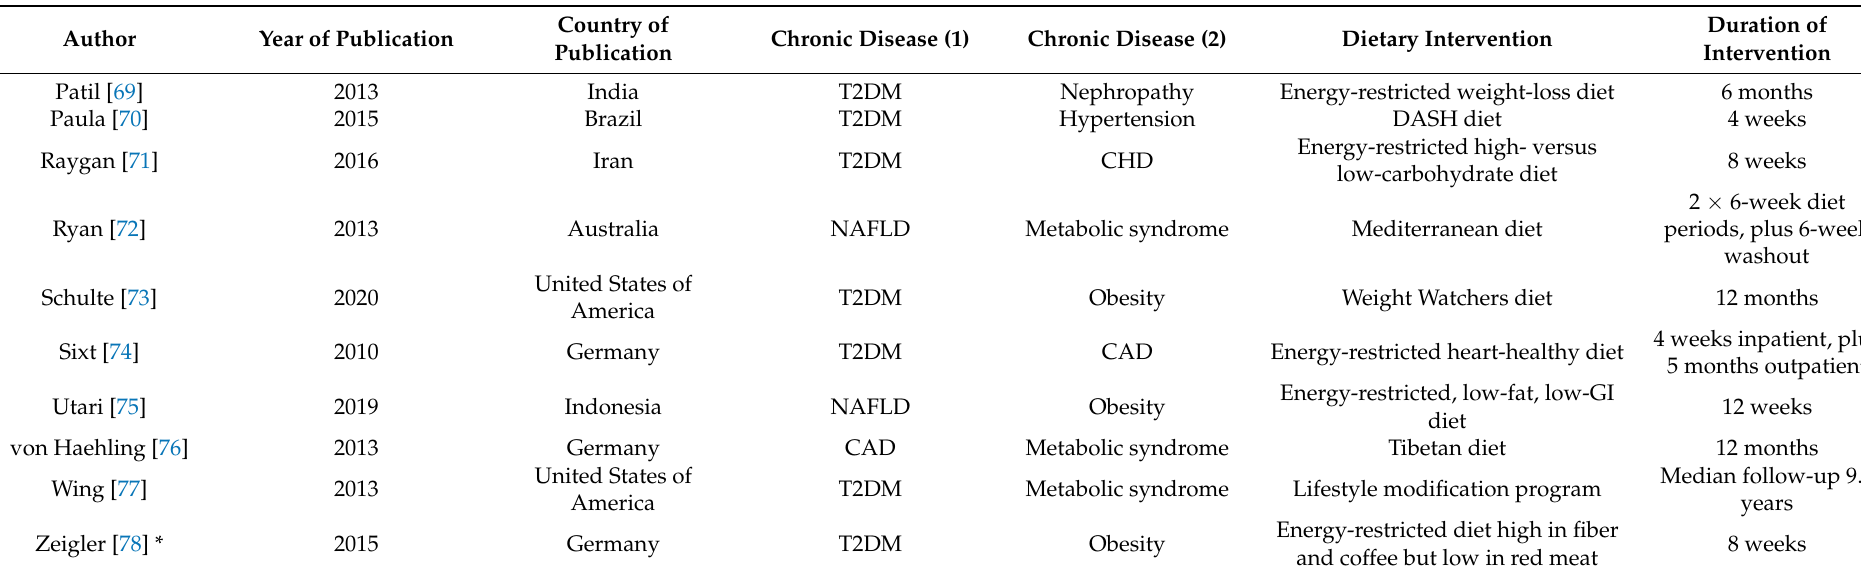
AF: atrial fibrillation, CAD: coronary artery disease, CKD: chronic kidney disease, CVD: cardiovascular disease, DASH: Dietary Approaches to Stop Hypertension, GI: glycaemic index, IHD: ischemic heart diseases, MetS: metabolic syndrome, monounsaturated fat, NAFLD: non-alcoholic fatty liver disease, PUFA: polyunsaturated fat, T2DM: type two diabetes mellitus, VLED: very low energy diet. * publications are from the same study (clinicaltrials.gov